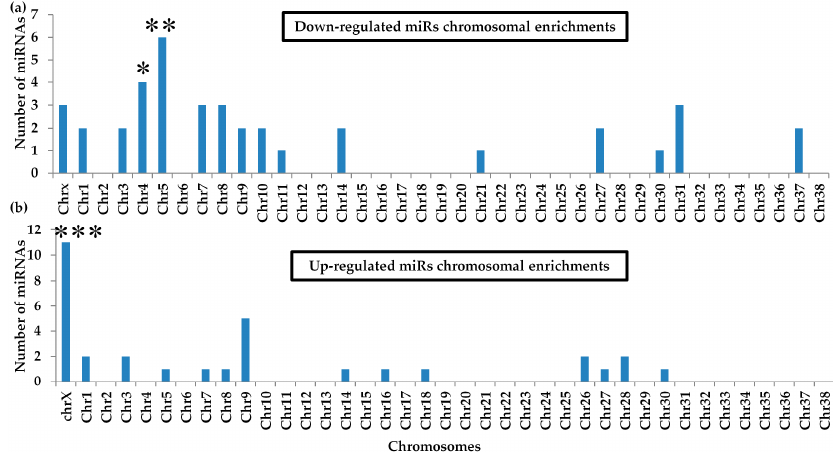
Figure 5. Chromosomal enrichment of differentially expressed miRNAs (miRs): ( a ) Chromosome enrichment of the down-regulated miRNAs, ( b ) Chromosome enrichment of the up-regulated miRNAs. Hypergeometric test, * P < 0.05, ** P < 0.01, *** P < 0.001.